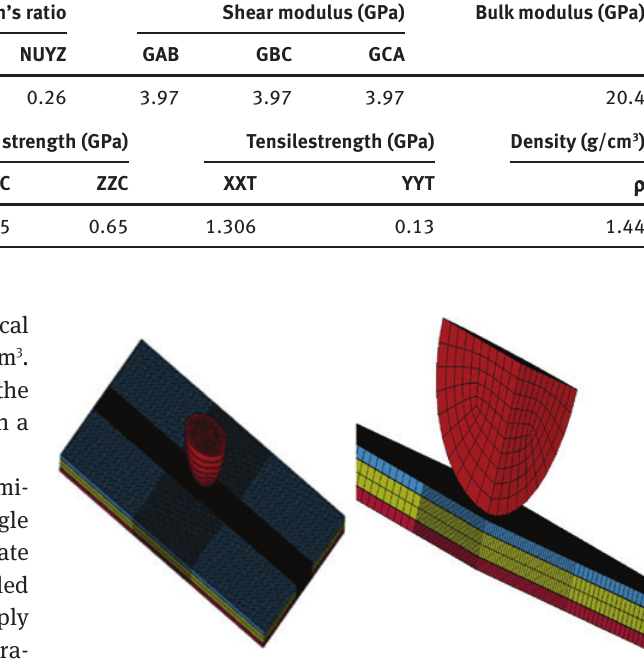
Figure 10: Geometric modeling